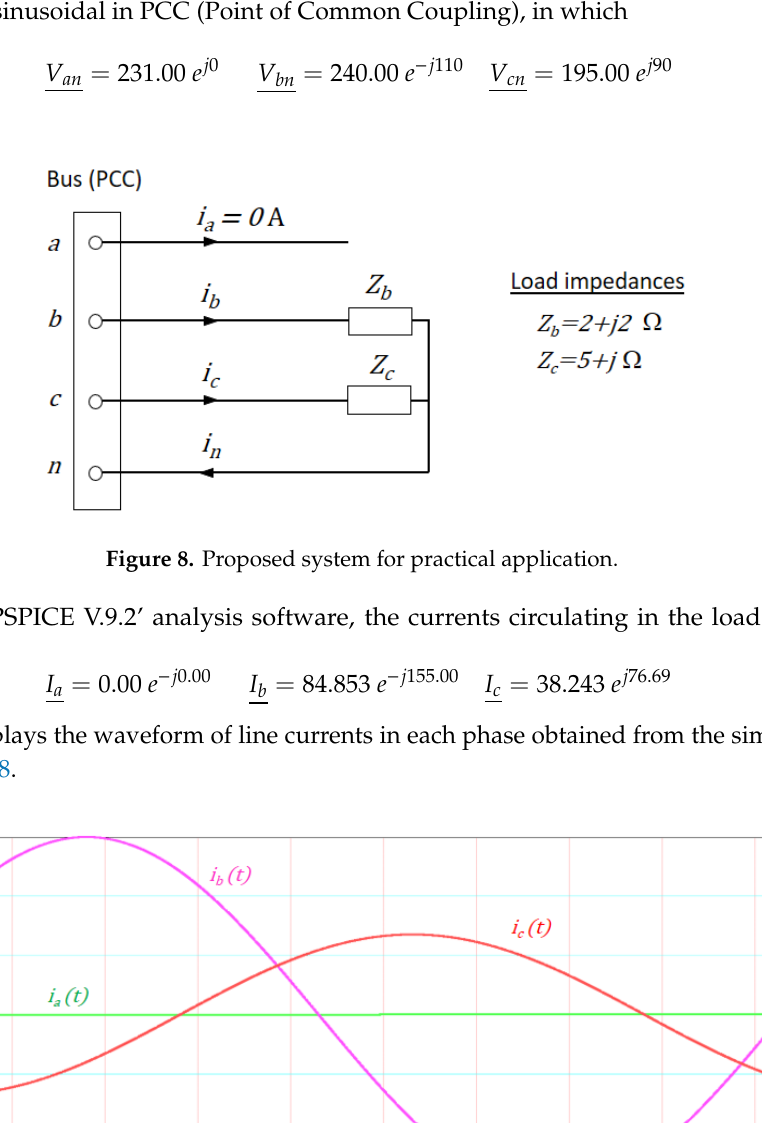
Table 1. Positive-, negative-, and zero-sequence voltages.